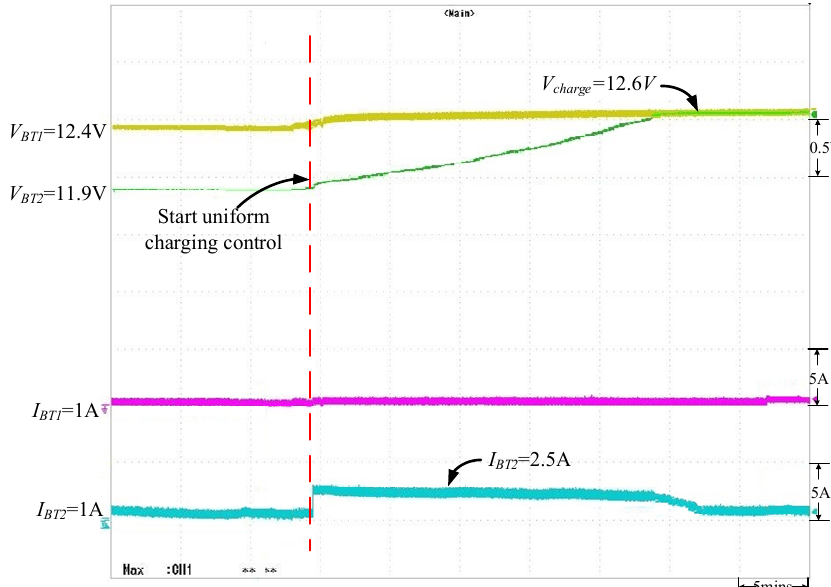
Figure 16. When V BT 1 = 12.4 V, V BT 2 = 11.9 V, uniform charge control response.